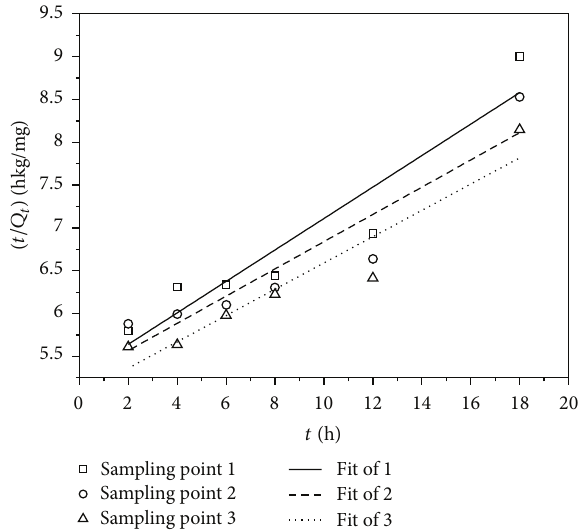
Figure 5: Simulated results of pseudo-second-order